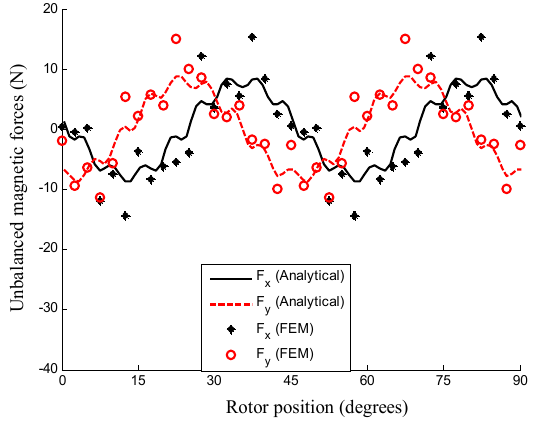
Figure 15. Unbalanced magnetic forces just due to the PMs.